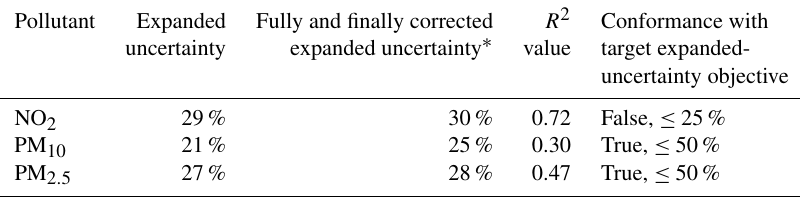
Table 7. Expanded-uncertainty estimates for fully corrected sensor observations from an unseen dataset for December 2020 (the target values are the target expanded-uncertainty criteria recommended by European legislation). Pollutant Expanded Fully and finally corrected R 2 Conformance with uncertainty expanded uncertainty ∗ value target expanded- uncertainty